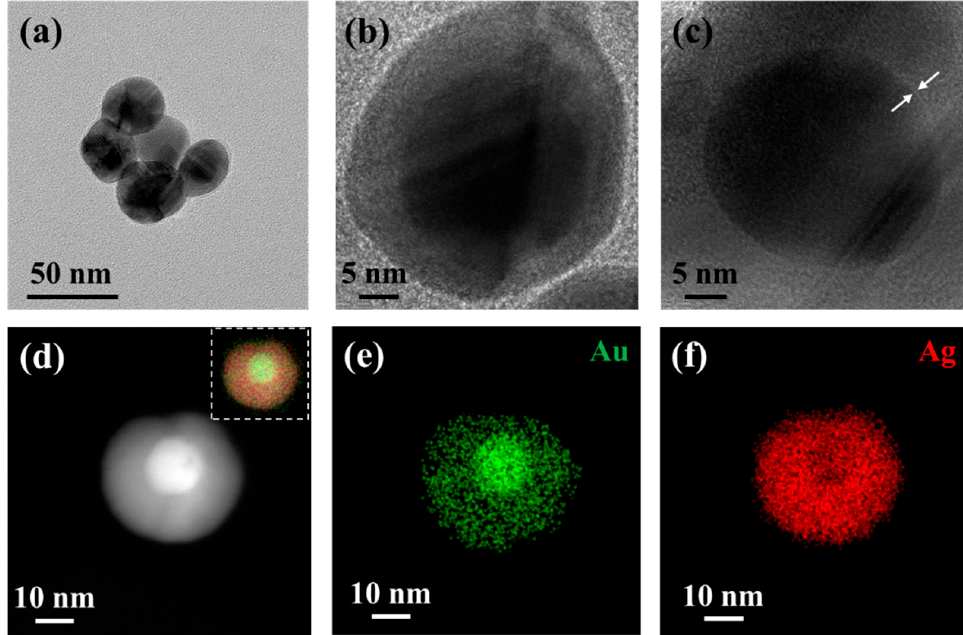
Figure 3. ( a , b ) HRTEM images of Au@Ag NSs; ( c ) HRTEM image of Au@4-MBA@Ag NSs; ( d , e ) images and EDS elemental maps of Au@Ag (inset image is superimposed image of Au and Ag signals).